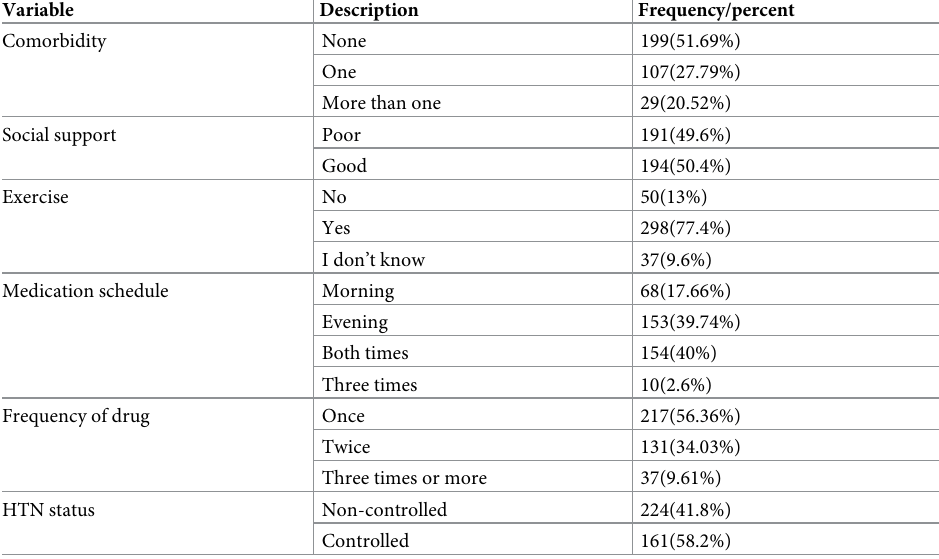
Table 2. Clinical and modifying factors of the study participants (n = 385) in Gondar public health facilities, Northwest Ethiopia,